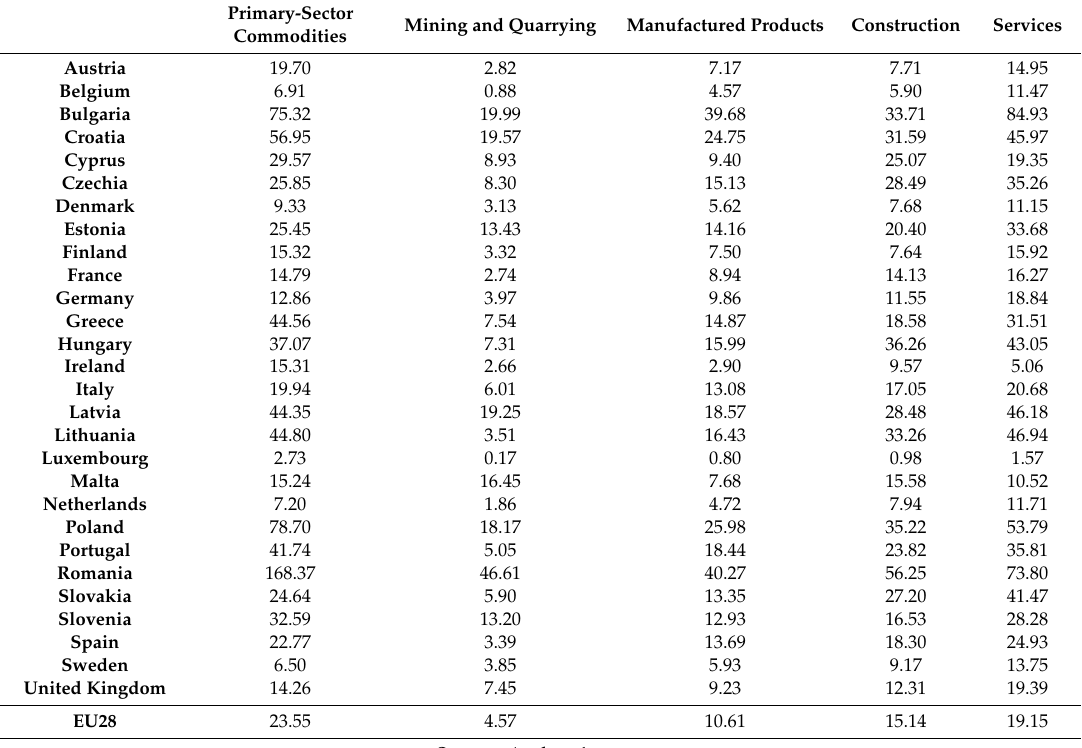
Table A3. Average employment (jobs) reduction per 1 million euros of demand reduction. Primary-Sector Commodities